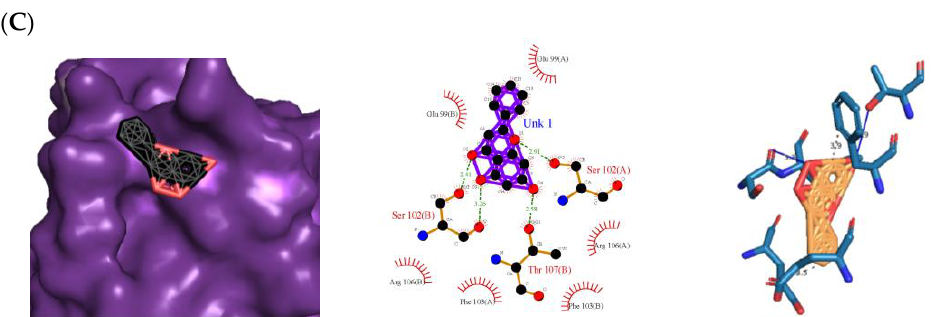
Figure 3. Top protein–ligand complex 3D structures, 2D and 3D ligand–protein interaction diagrams from LigPlot for antioxidant activity. ( A ) 1CB4-naringenin complex; ( B ) 2CAG-naringenin complex; ( C ) 2P31-pinocembrin complex. amino acid residues: Gly 145(B), Cys 6(A), Val 146(A and B), Val 7(A and B) for 1CB4 protein, Gly 110(A), His 54(A), Phe 111(A), Arg 51(A), Ala 112(A), Val 125(A), and Tyr